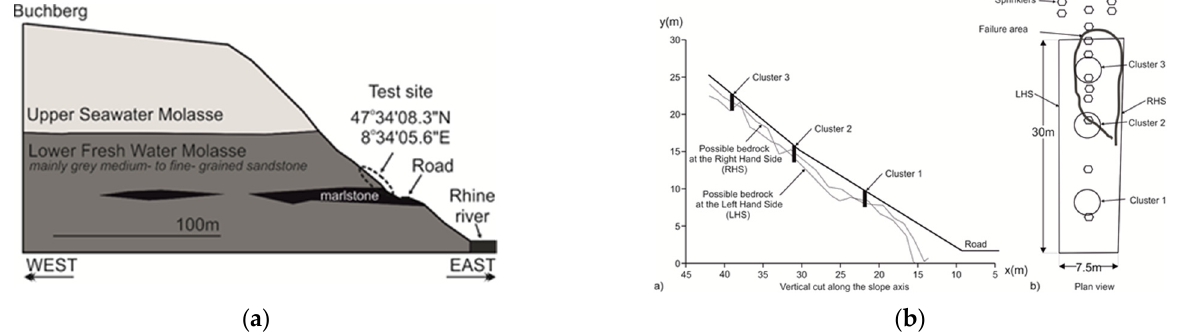
Figure 4. ( a ) Geomorphology of the greater experimental area (after [20]); ( b ) a schematic of the bedrock topography and of the instrumented area of the experiment (after [22]).